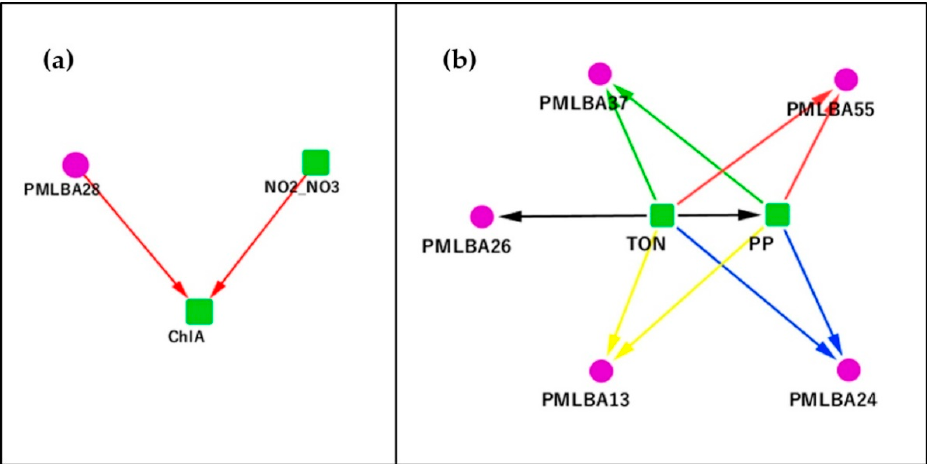
Figure 3. The Granger causality subnetwork of Ch1A and TON-PP of Plymouth Marine Lab (PML) data. A green square represents an environmental factor. A purple circle represents an OTU. ( a ) A subnetwork centered on Ch1A, whose level was only casually affected by the NO2_NO3 and PMLBA28 levels. ( b ) A subnetwork centered on the TON-PP pair, which jointly causally affected four bacterial OTUs.